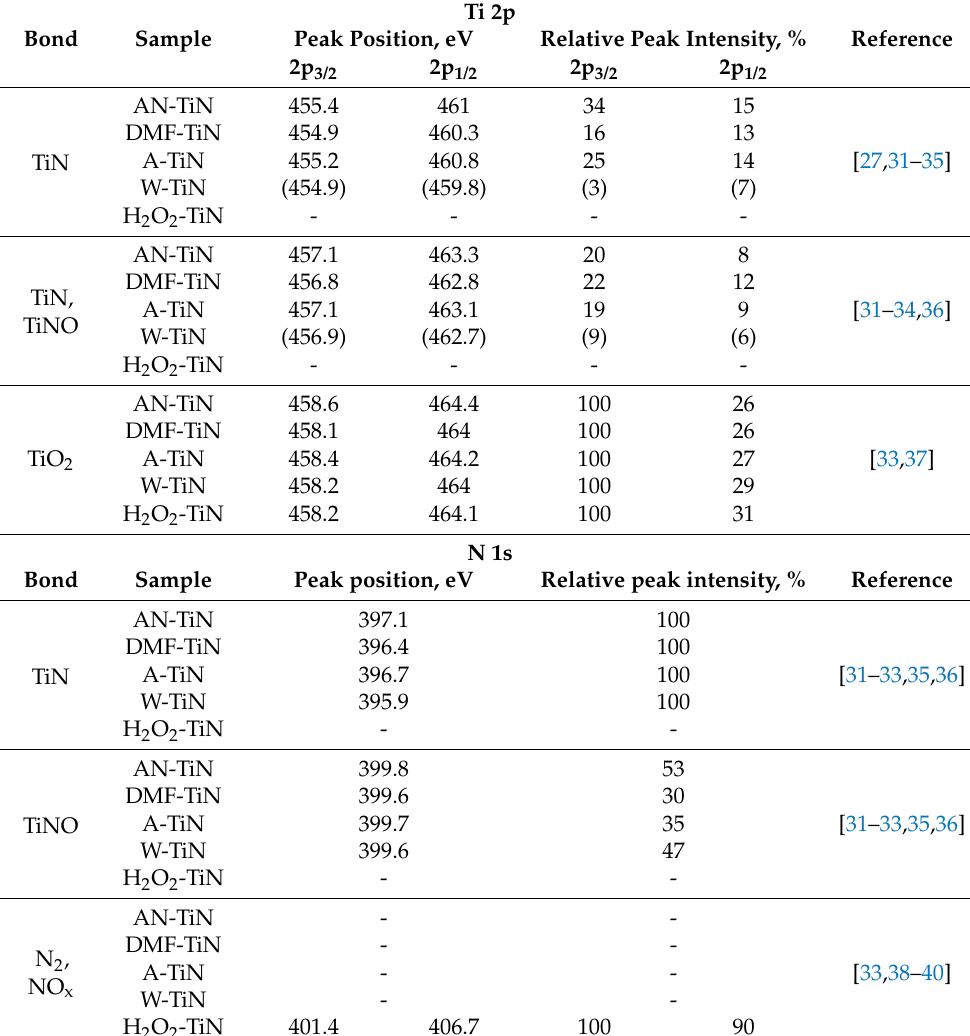
Table 1. Results of deconvolution of Ti 2p and N 1s XPS spectra of the synthesized NPs. Values in parenthesis represent alternative six-peak fit for W-TiN